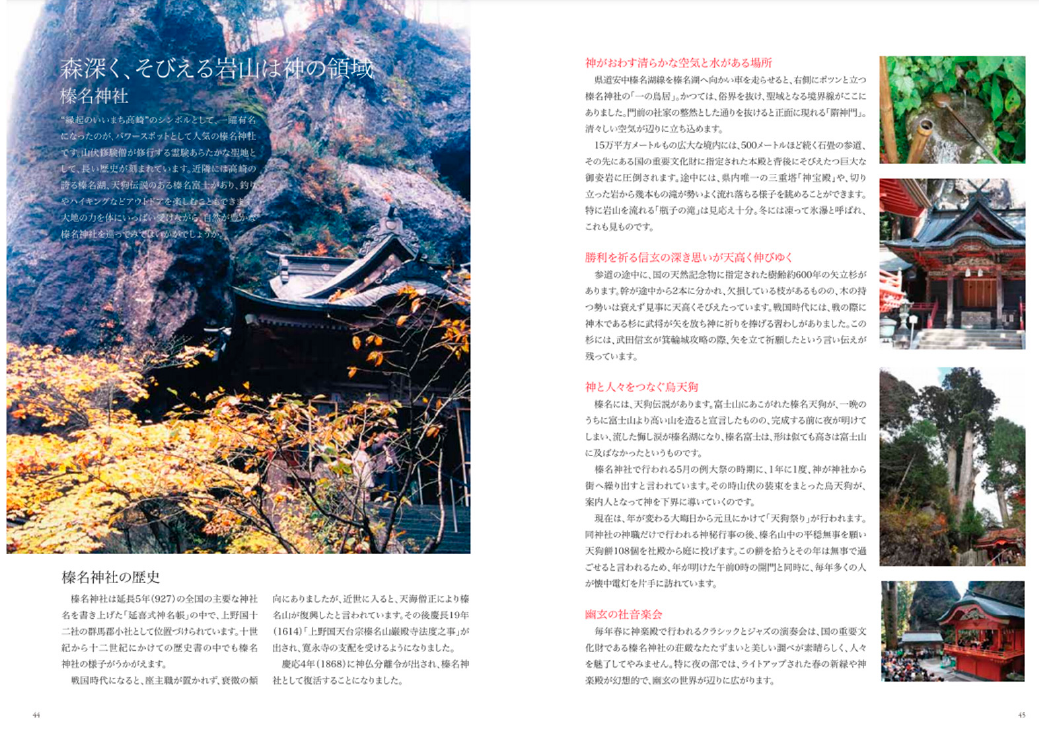
Figure 4. Explanation of History and Contemporary Significance of Haruna Shrine by Local Administration Guidebook. Source: (CTBEC 2014, pp. 44–45).